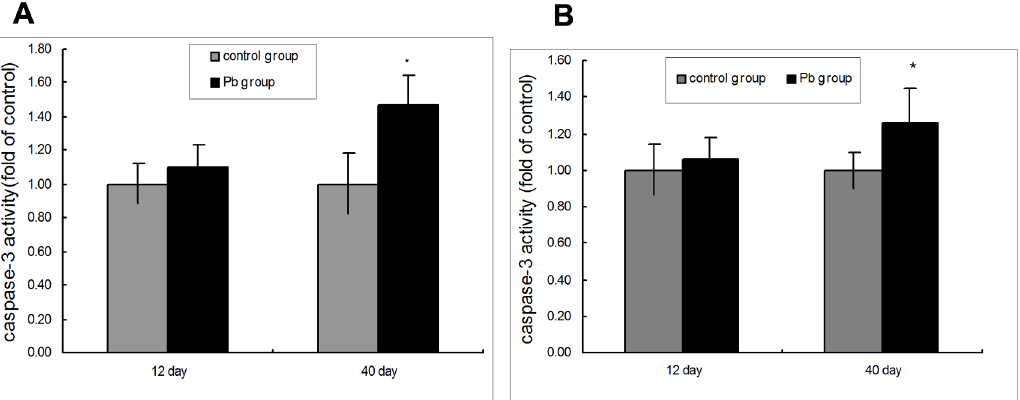
Fig 5. Pb-induced caspase-3 activation in cardiovascular tissue. (A) Caspase-3 activity in rat vascular following Pb exposure. (B) Caspase-3 activity in rat cardiac tissue following Pb exposure. The rats were treated with 1% Pb acetate for 12 and 40 days. n = 6. Data are the means ± SD. * p < 0.05 compared with the control group. The relative activities of caspase-3 shown are calculated from the average of experiment. Each value was expressed as the ratio of caspase-3 activation level to the control level, and the value of the control was set to